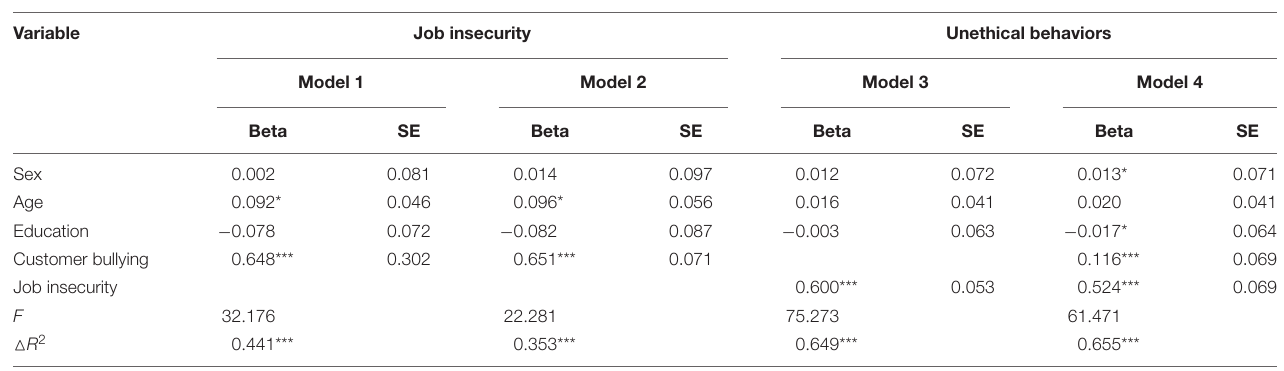
TABLE 5 | Regression results for direct and mediating effects.